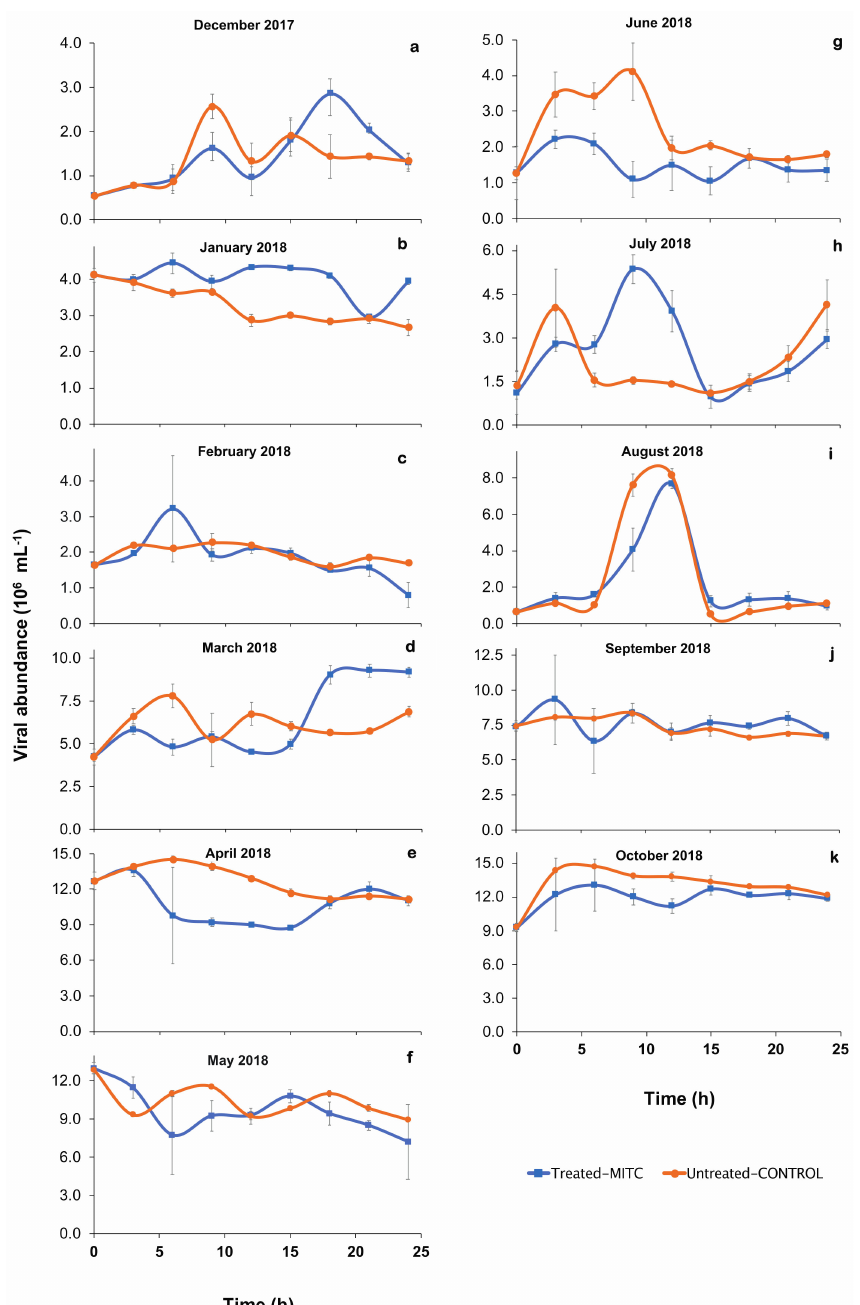
Figure 3. Viral abundance during the monthly 24-h incubations performed for the induction of lysogens. The plots ( a – k ) represent different months of induction. Error bars are standard errors of three replicates for each incubation